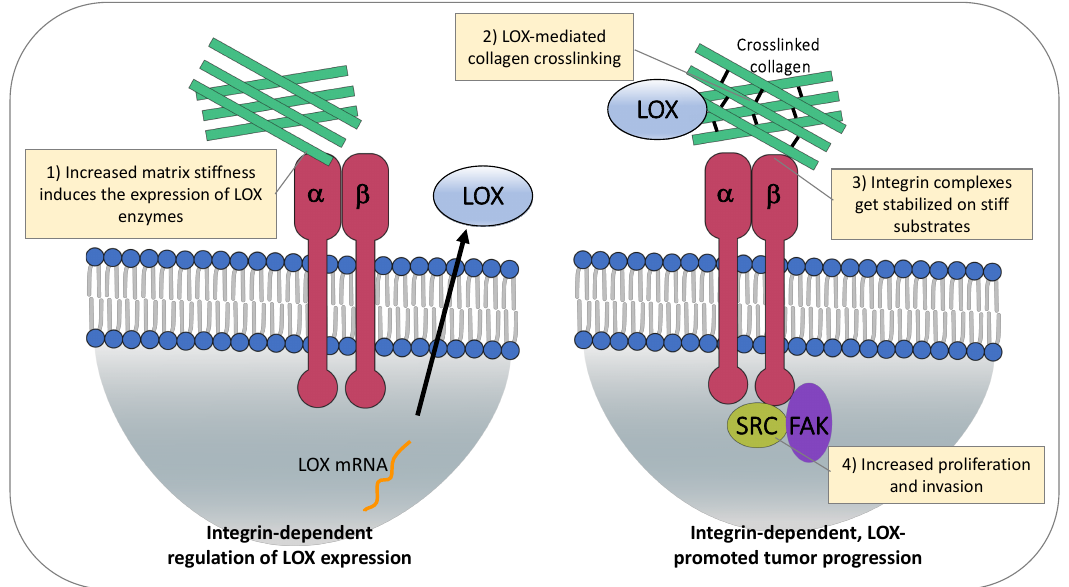
Figure 2. Matrix sti ff ness induces expression of LOX enzymes and promotes tumor progression. On the left, regulation of LOX expression. Interaction of α 2 β 1 integrin to collagen type I promotes LOX expression in stromal cells. ECM sti ff ness induces LOXL2 upregulation via activation of integrin β 1 / α 5 / JNK / c-JUN signaling pathway in HCC cells. On the right, e ff ects of sti ff ECM on cancer cells. LOX mediates collagen crosslinking and ECM sti ff ness, resulting in stabilization of integrin complexes and increased cancer cell proliferation and